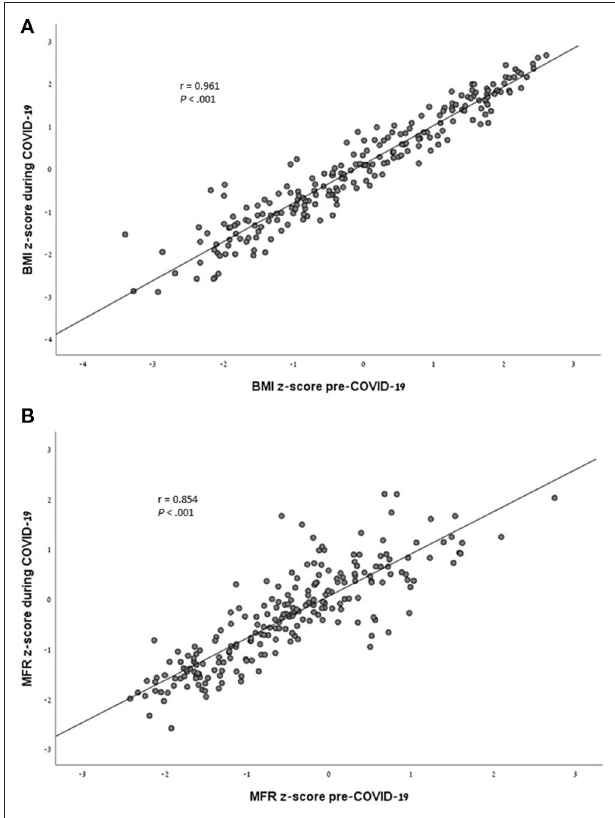
FIGURE 1 | (A) Analysis of the correlation between the BMI z-scores of subjects before and during the COVID-19 pandemic ( r = 0.961, P < 0.001). (B) Analysis of the correlation between the MFR z-scores of subjects before and during the COVID-19 pandemic ( r = 0.854, P < 0.001).